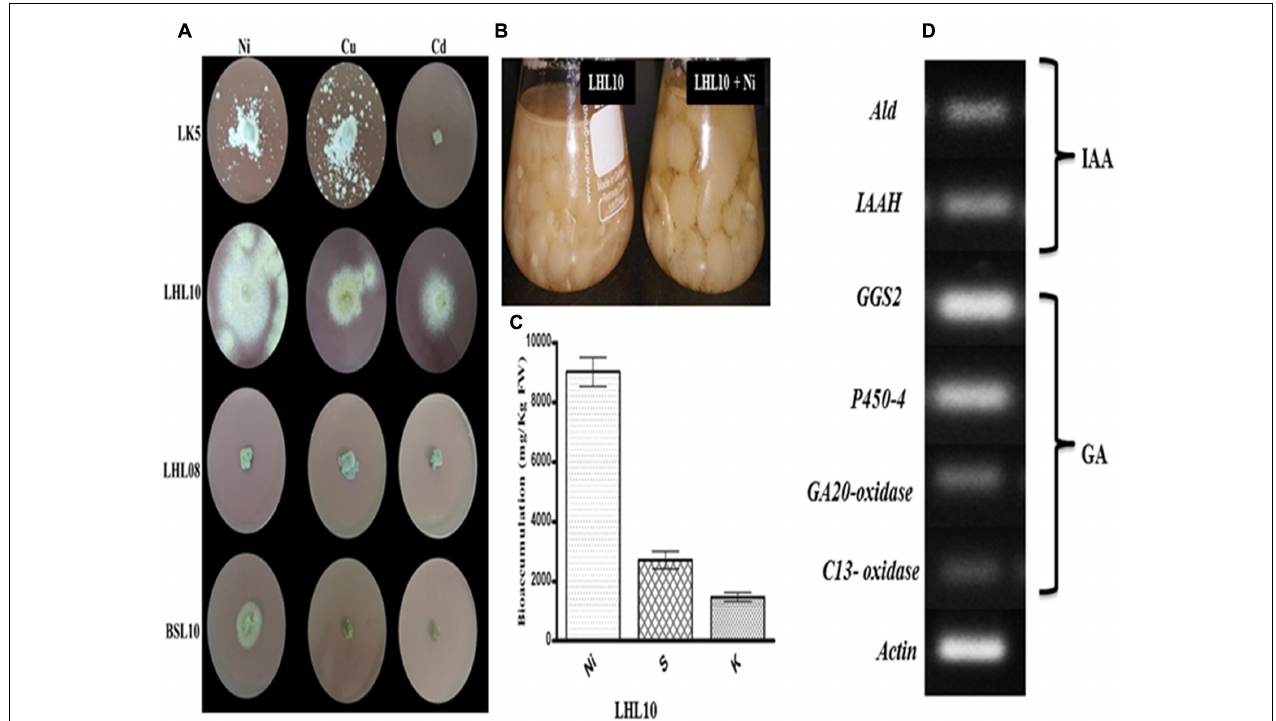
FIGURE 1 | Growth dynamics of selected fungal endophytes in 1.0 mM Ni, Cu, Cd amended mediums. (A) Each fungus was screened against metals toxicity and their ability to survive. The diameter of growing mycelia was measured after 7 days of incubation at 25 ◦ C. (B) On the base of significant growth in Ni stress, LHL10 was grown in PDB medium for metal and nutrient uptake analysis. (C) Metal uptake analysis via ICP-MS. (D) Genes expression related to gibberellins (GAs) and indole acetic acid (IAA) biosynthesis of P. formosus . LHL10. Indole-3-acetamide hydrolase (IAAH), aldehyde dehydrogenase ( Ald ) are IAA related genes, while GAs related genes are geranylgeranyl-diphosphate synthase (GGS2), ent-kaurene oxidase (P450-4) , GA 20-oxidase and C13-oxidase (P450-3) . The (A) is representative of five replications whereas (B) and (C) are repeated three